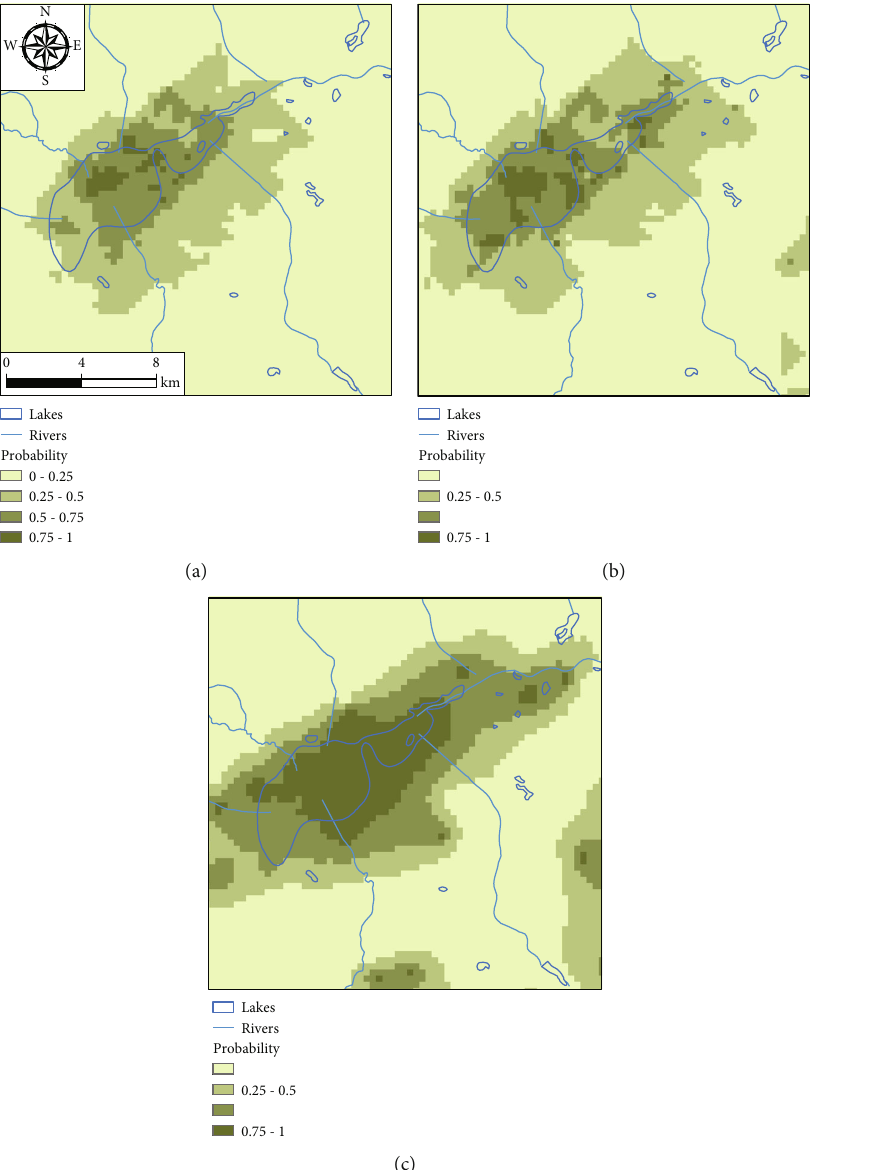
Figure 8: Probability spatial distribution of groundwater depth under di ff erent thresholds: (a) 1.5m; (b) 3.0 m; (c) 4.0